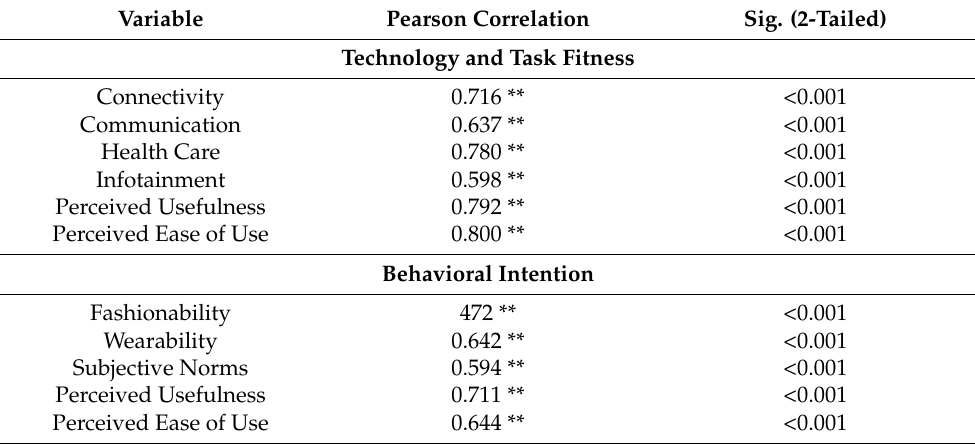
Table 2. Factors affecting technology and task fitness (TTF) and Behavioral Intention to use Wearable Devices [N = 495].